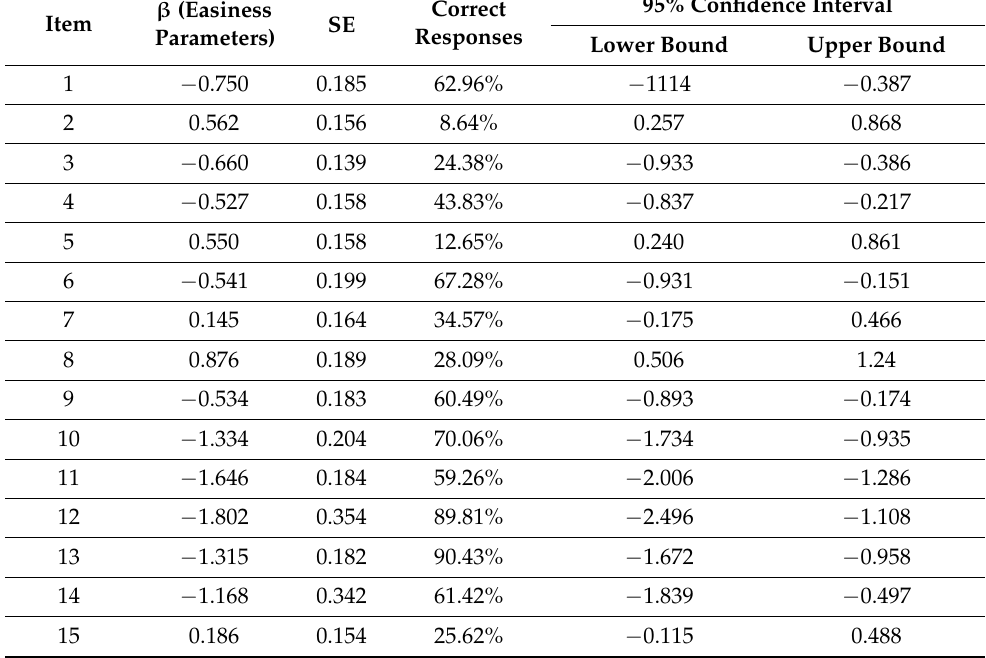
Table 3. Adjustment statistics for the 15